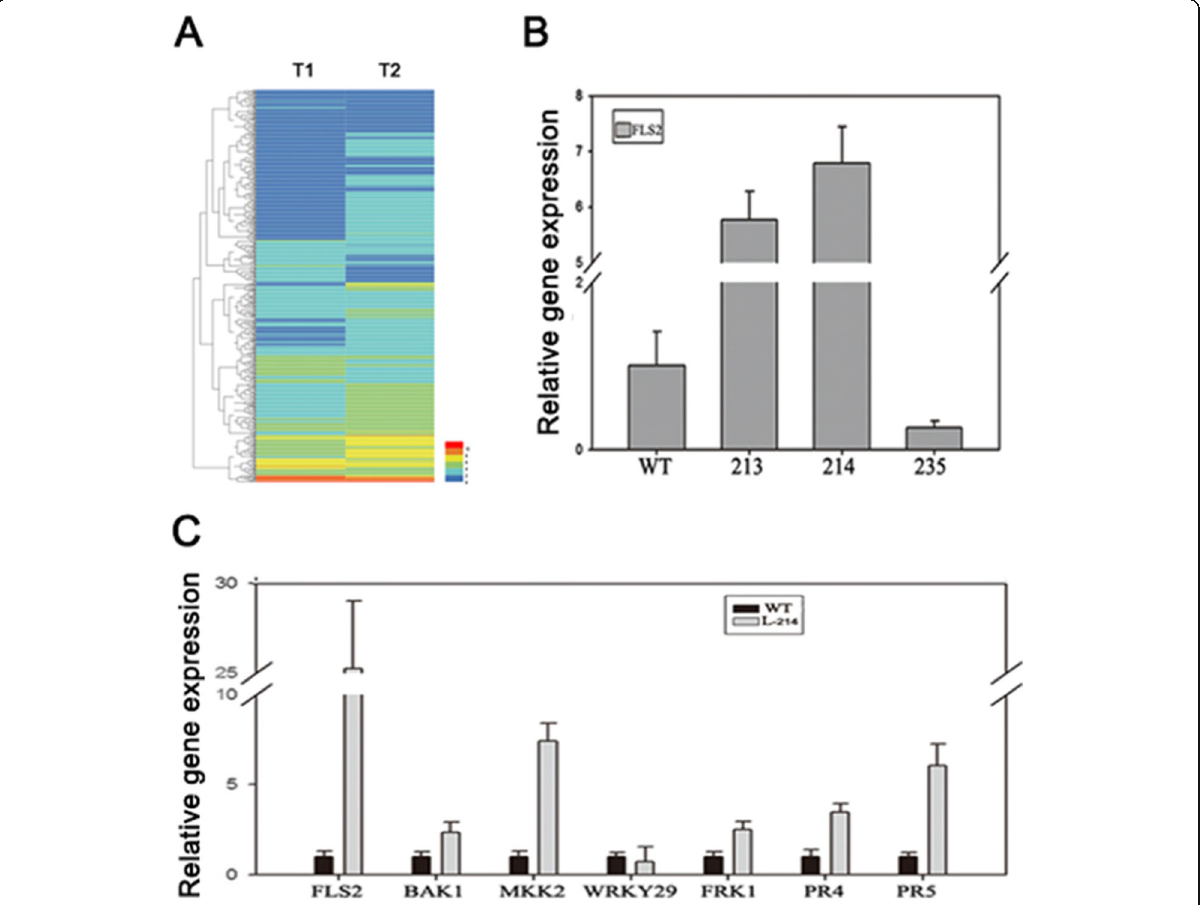
Fig. 3 GbAt11 overexpression in G. hirsutum up-regulates expression of multiple key genes in the PTI and ETI pathways a Heat map clustering of differentially expressed genes; T1 is the parental line JM169, and T2 is the transgenic line L-214. Colors represent the relative gene expression level in each sample; blue indicates low level of expression, and red indicates high level of expression. b The relative expression of FLS2 gene in indicated G. hirsutum lines. c The relative expression of indicated genes related to PTI and ETI pathway in L-214 line and the parental line